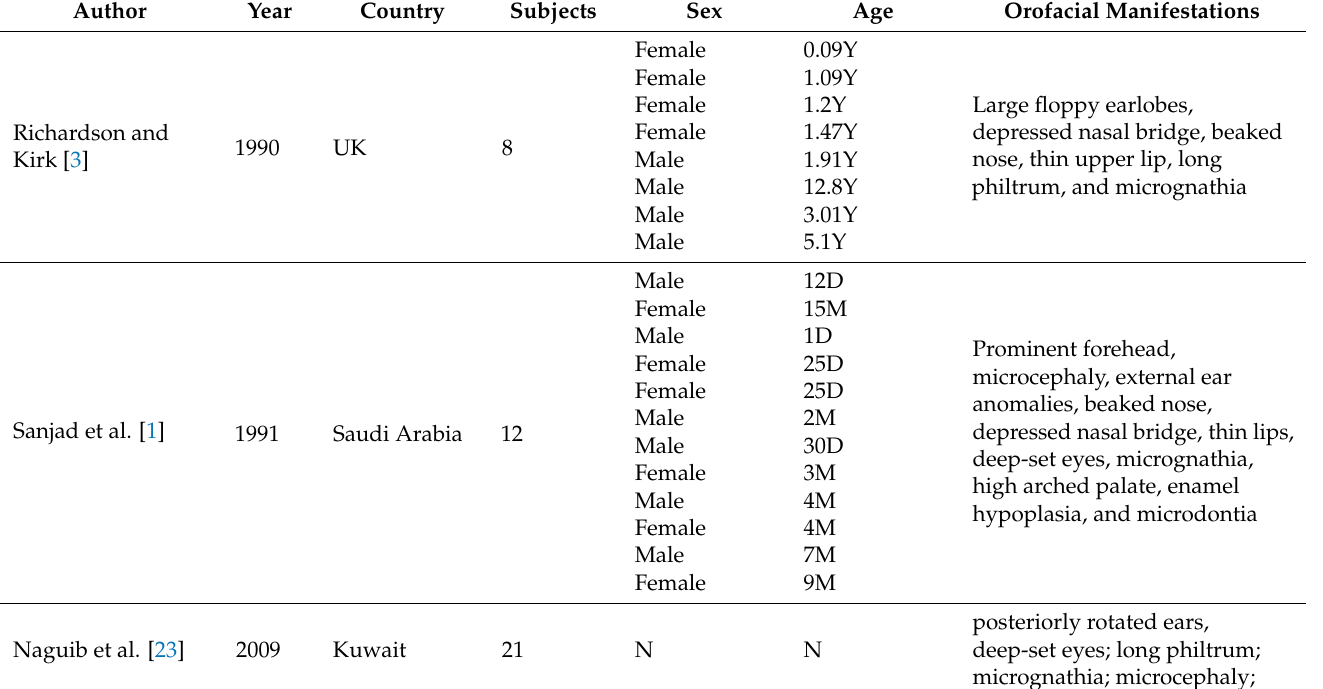
Table 2. Case series studies reported on orofacial manifestations of Sanjad–Sakati